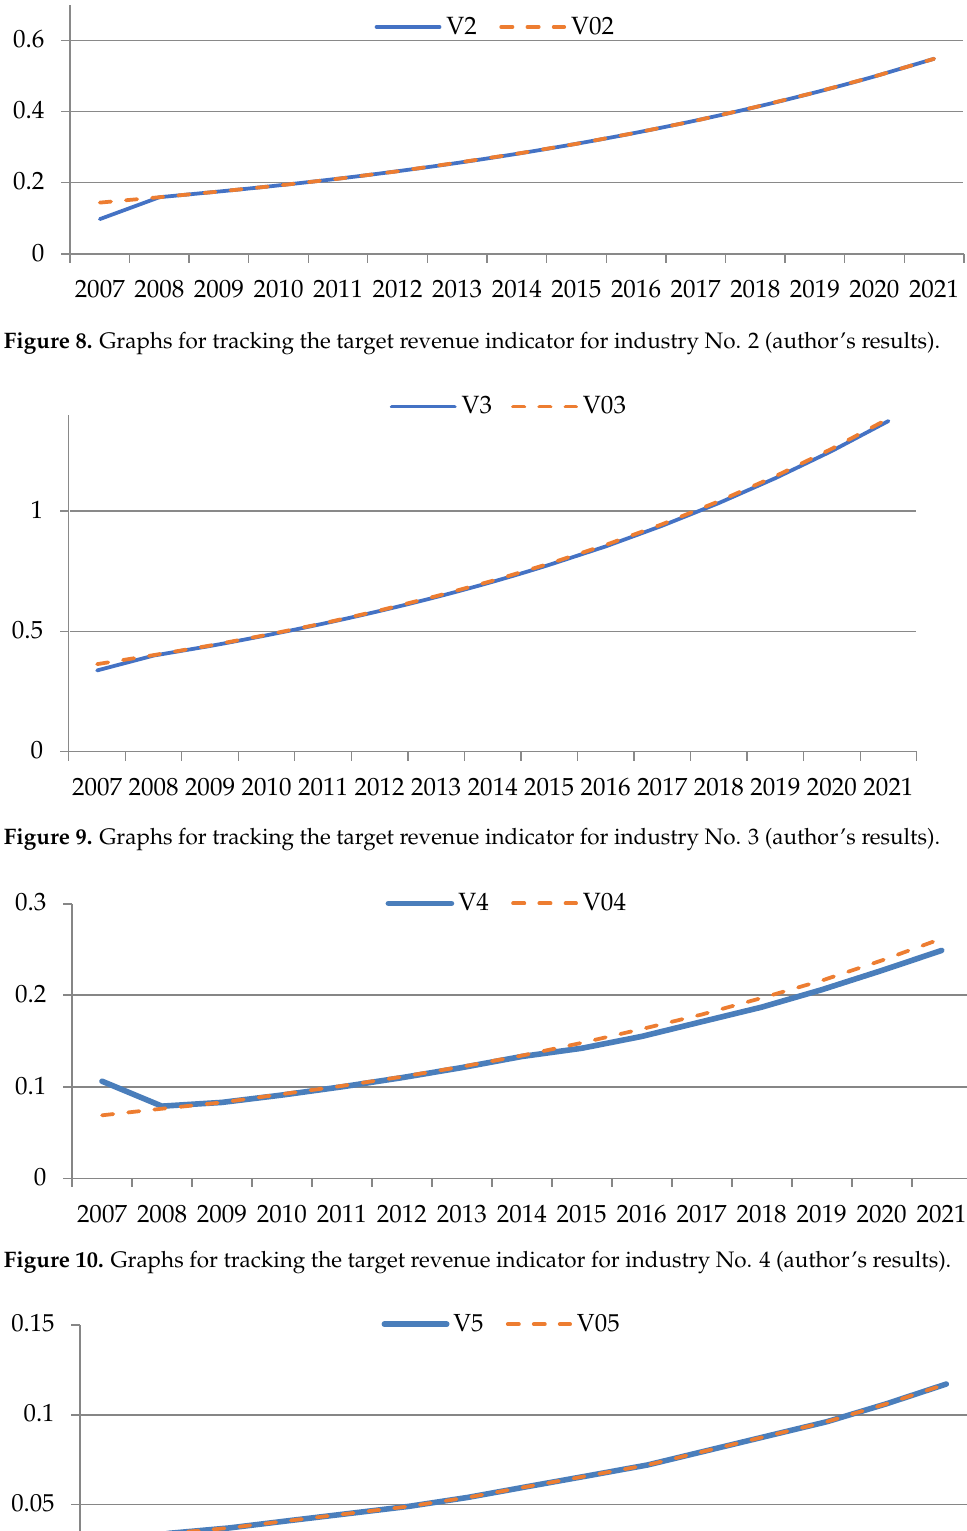
Figure 7. Graphs for tracking the target revenue indicator for industry No. 1 (author’s results).